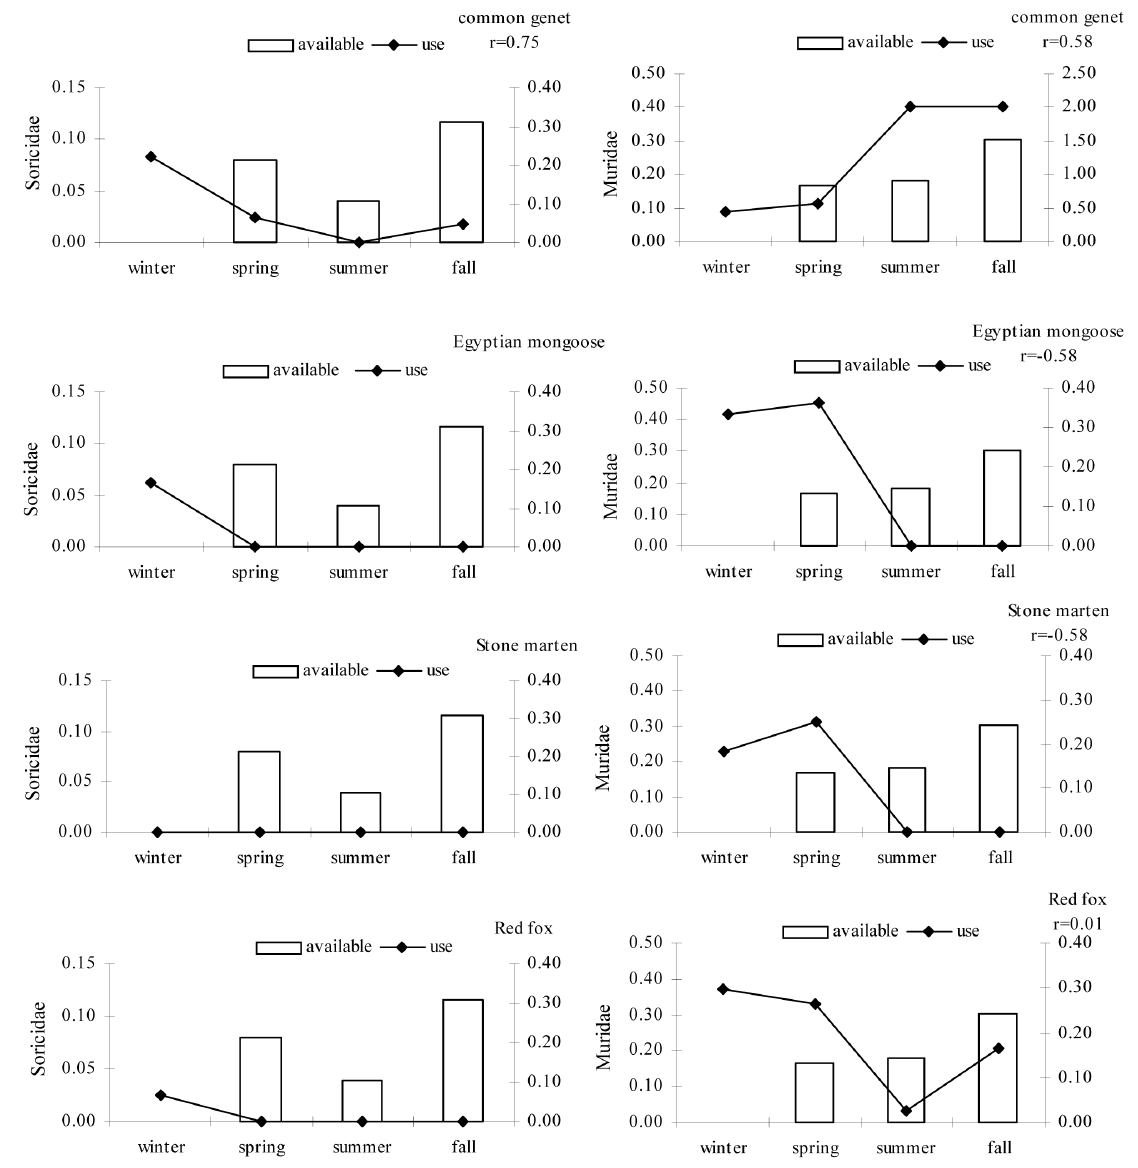
Fig. 4. Seasonal variation of use vs availability of Soricidae ( Crocidura russula ) and Muridae ( Apodemus sylvaticus , Mus spretus, and Rattus rattus ) in the diet of common genets, Egyptian mongooses, stone martens and red foxes in the study area (r – correlation coefficients; when availability and consumed data were not coincident estimates of r were not attained; * – denotes significance at p<0.05; **– denotes significance at